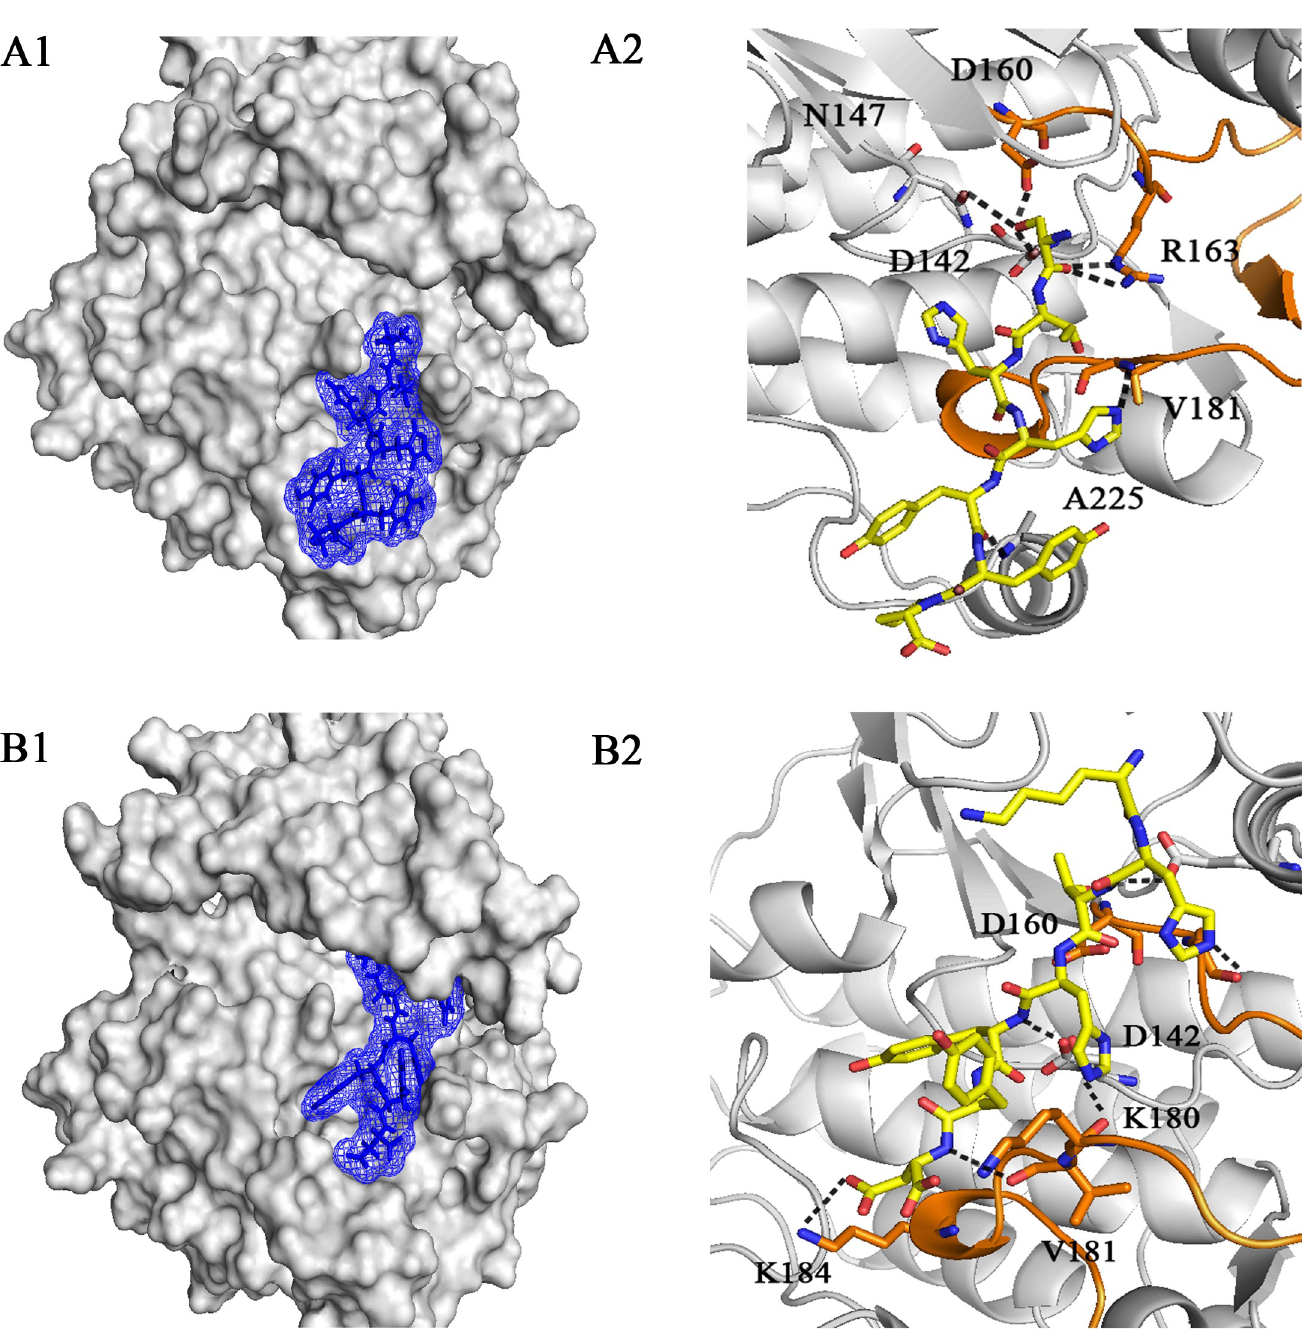
Fig 2. 3D representation of peptides 5 and 26 in interaction with the peptide-substrate binding site of EGFRL858R. Overview and detailed view of interactions of peptide 5 (A1 and A2) and peptide 26 (B1 and B2) with EGFRL858R. (A2) Peptide 5 formed 7 hydrogen bonds with residues, Asp 142 to Ala 225 of the peptide- substrate binding site. (B2) peptide 26 formed 7 hydrogen bonds with residues, Asp 142 to Lys 184 of EGFR kinase domain. The peptides are shown in stick model. Black dotted lines indicate hydrogen bonds. The key residues of peptide-substrate binding site are illustrated in stick model.